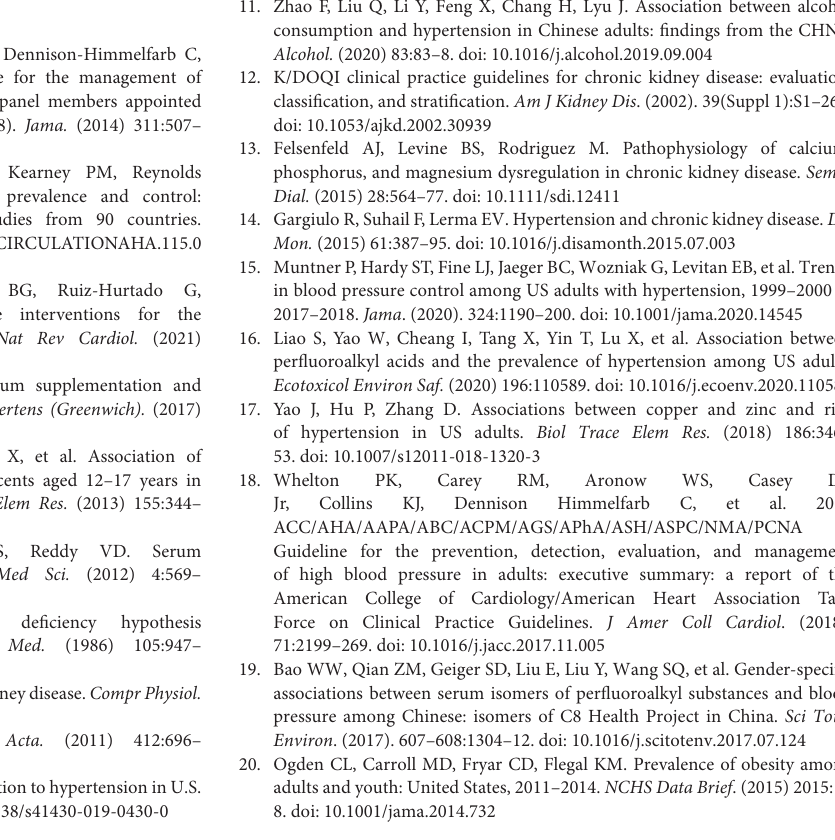
Supplementary Figure 1 | The ROC curve of the model performance in the testing set. All individuals were randomly divided into a training set and testing set at a ratio of 7:3. We used the training set to create a predictive model, whereas the testing set was used to evaluate the model performance. Serum calcium showed a poor identifying performance of the prevalence of hypertension, with an AUC of 0.53, sensitivity of 0.23, specificity of 0.81, positive predictive value of 0.55, and negative predictive value of 0.52. AUC: area under the